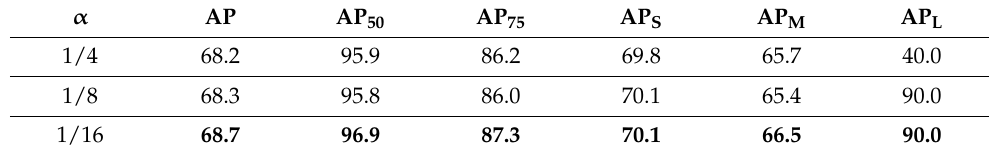
Table 8. Ablation experiment results of factor α on the Instance-RSDD dataset.